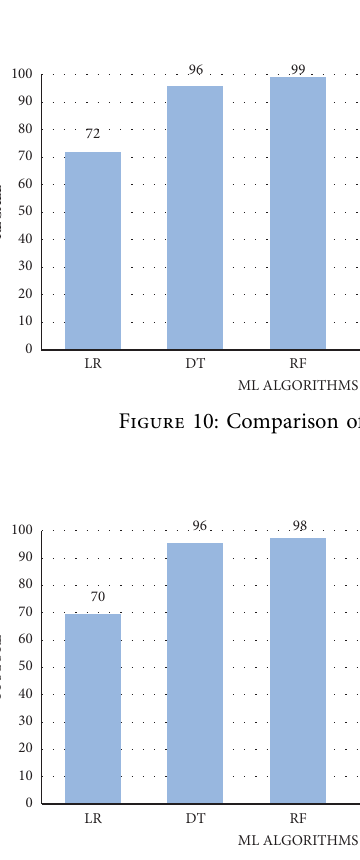
Figure 11: Comparison of F1 score.